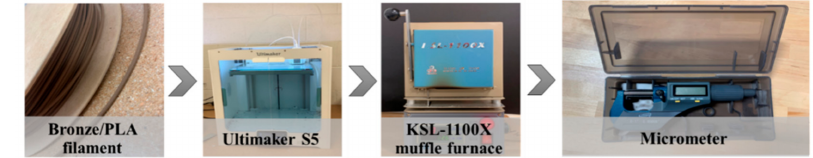
Figure 1. Material and equipment used in this research.